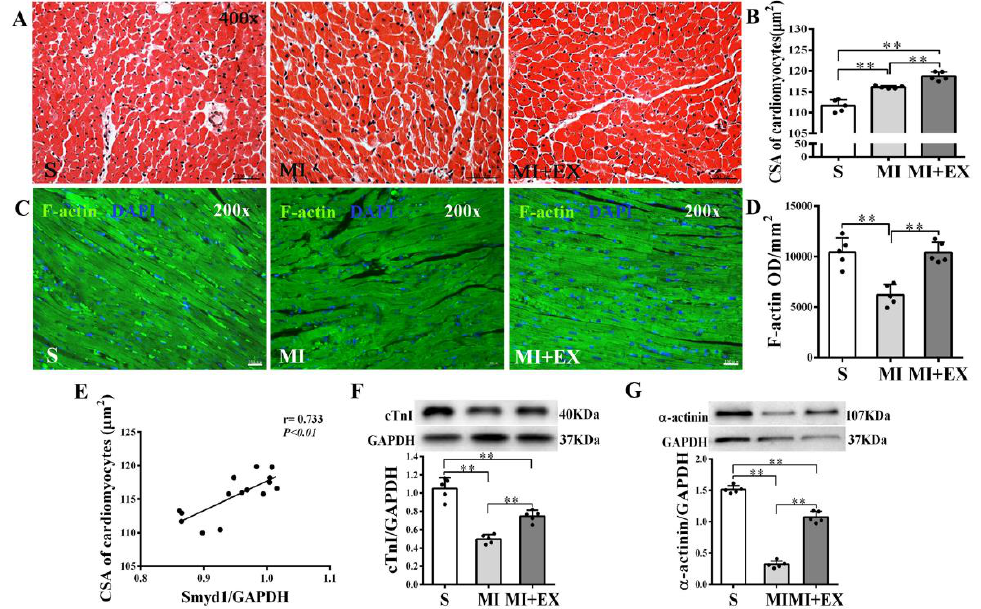
Figure 3. Effects of post-myocardial infarction (MI) exercise training on cardiomyocyte size in infarcted rat hearts: ( A ) Hematoxylin eosin (HE)-stained heart sections from the peri-infarcted area (scale bar = 100 µm); ( B ) quantification of the surviving cardiomyocyte cross-sectional area (CSA, n = 5/group); ( C ) Fluorescein isothiocyanate (FITC)-phalloidin-stained heart sections from the peri-infarcted area of myocardium (scale bar = 100 µm); ( D ) Integrated optical density (IOD) of F-actin in the peri-infarcted area of myocardium ( n = 5/group); ( E ) correlation analysis among Smyd1 expression and CSA in cardiomyocytes ( n = 15); and ( F , G ) Western blot analysis of cTnI ( F ) and α-actinin ( G ) in the infarcted myocardium ( n = 5/group). Data are expressed as mean ± Standard Deviation (SD). Symbols indicate ** p < 0.01. Abbreviations: S, Sham group; MI, MI alone group; and MI + EX, post-MI exercise training group.